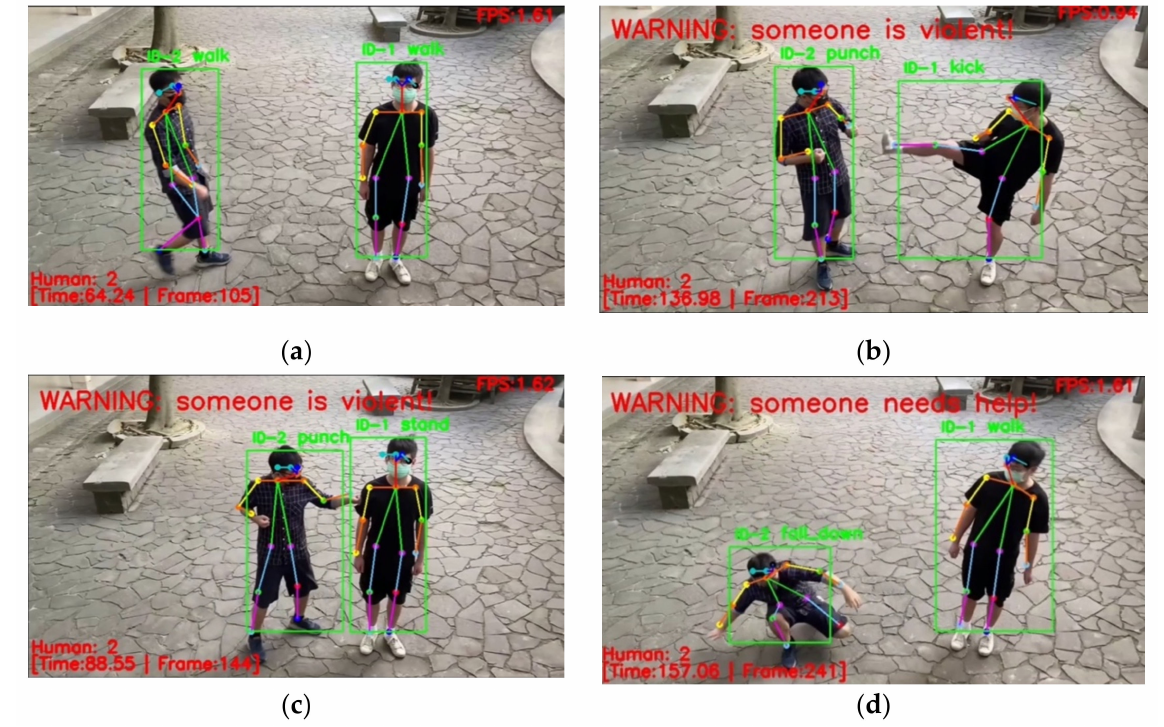
Figure 20. Outdoor behavior interpretation from the multiple postures recognized as: ( a ) Normal (both persons are walk posture); ( b ) Violent (one is punch and another is kick posture); ( c ) Violent (one is stand and another is punch posture); ( d ) Help needed (one is walk pose and another is fallen down posture).